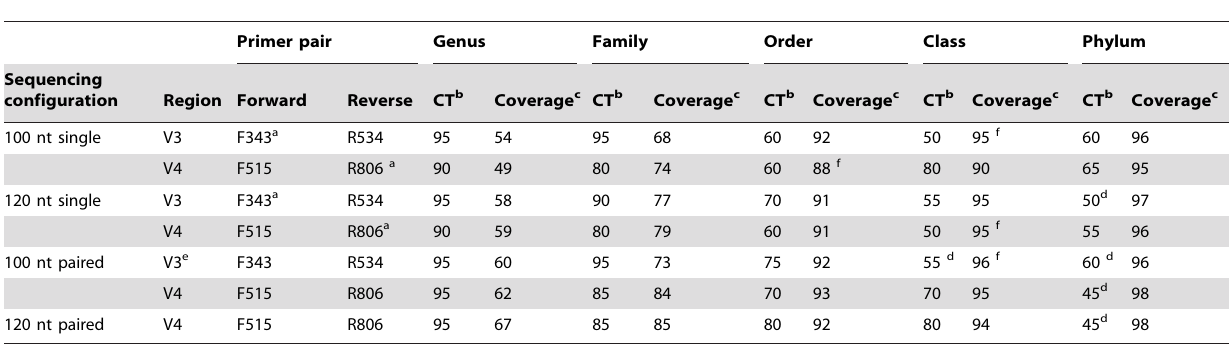
Table 3. Recommended experimental